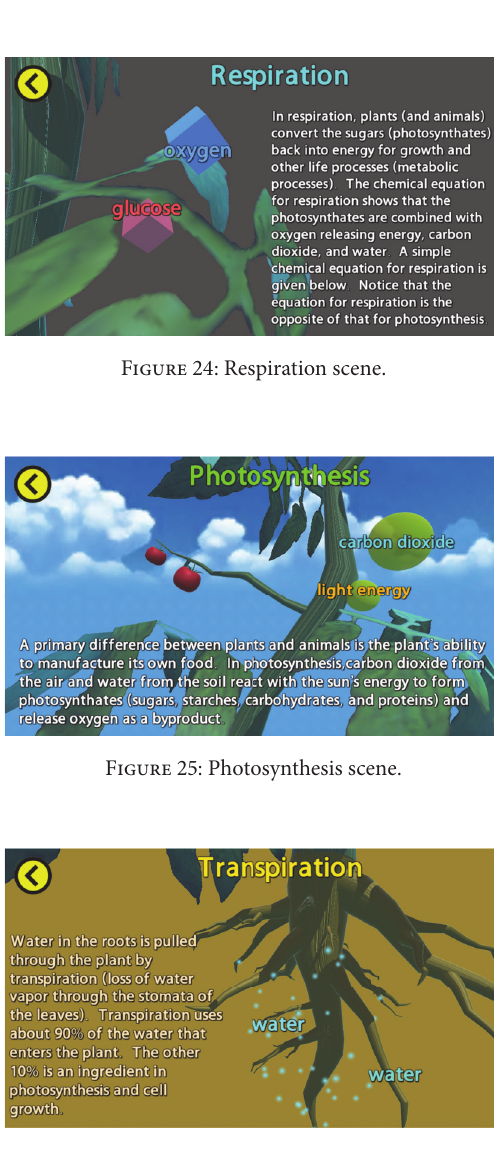
Figure 26: Transpiration